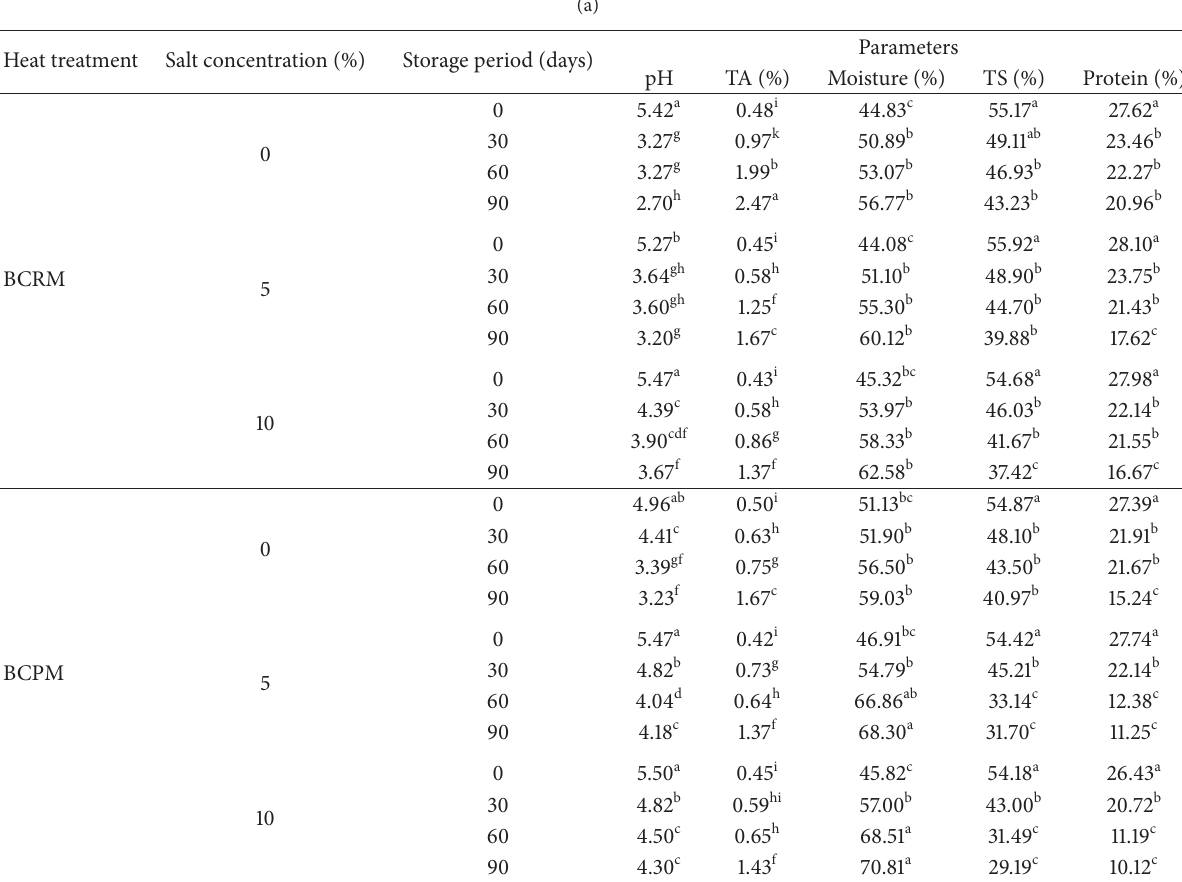
Table 1: Effect of heat treatment, salt concentration, and storage period on physicochemical properties of braided